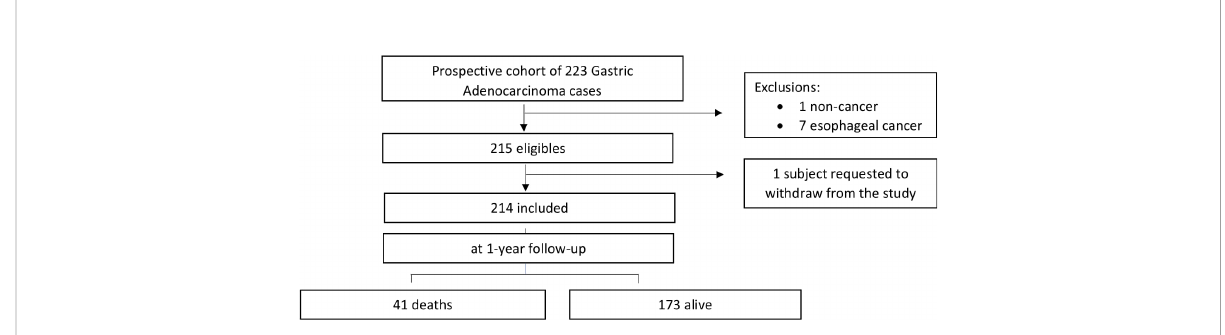
FIGURE 1 Summary of Gastric Adenocarcinoma cases status after one year follow-up and fl owchart of exclusion